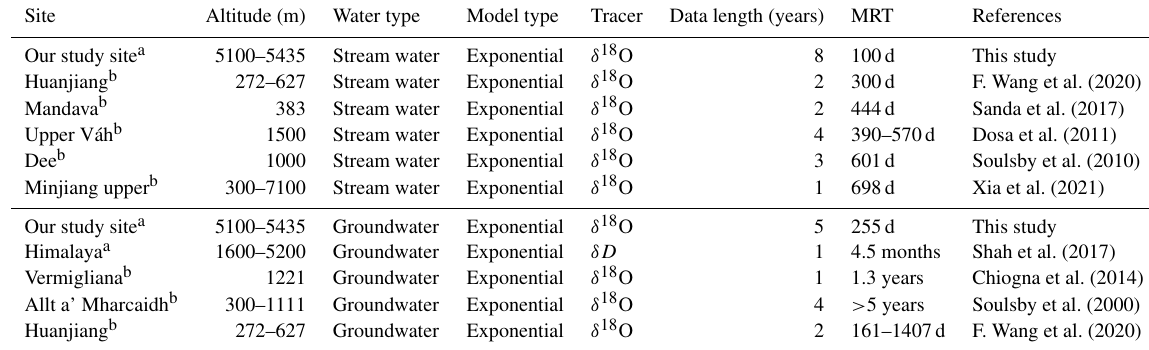
Table 5. Statistics of MRT-related research results.